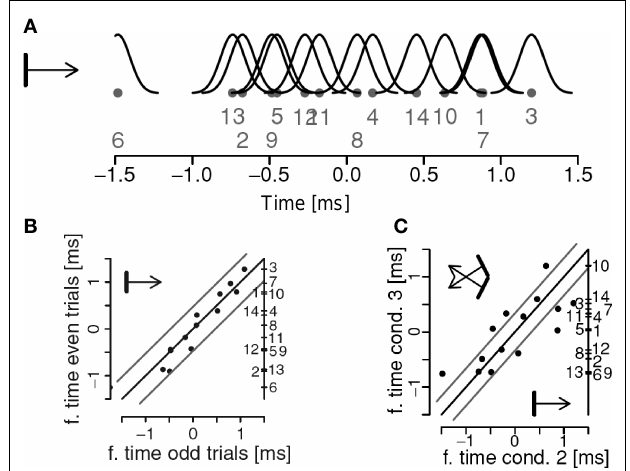
FIGURE 4 | The role of synchrony for perception of brightness. (A) In the two centre-surround stimuli, the gratings in the centre are physical identical. Nevertheless, most observers report seeing stronger contrast on the right where the centre is offset for 180 ° relative to the surround. (B) Experimental results obtained with stimuli shown in (A) . Red: Human psychophysical judgments of changes in perceived contrast as a function of phase offset between the centre and surround. Blue: Changes in the strength of synchronization between neurons in cat area 17 whose receptive fi elds were covered by the centre stimuli and whose orientation preferences matched the orientation of the grating. Adapted from Biederlack et al.